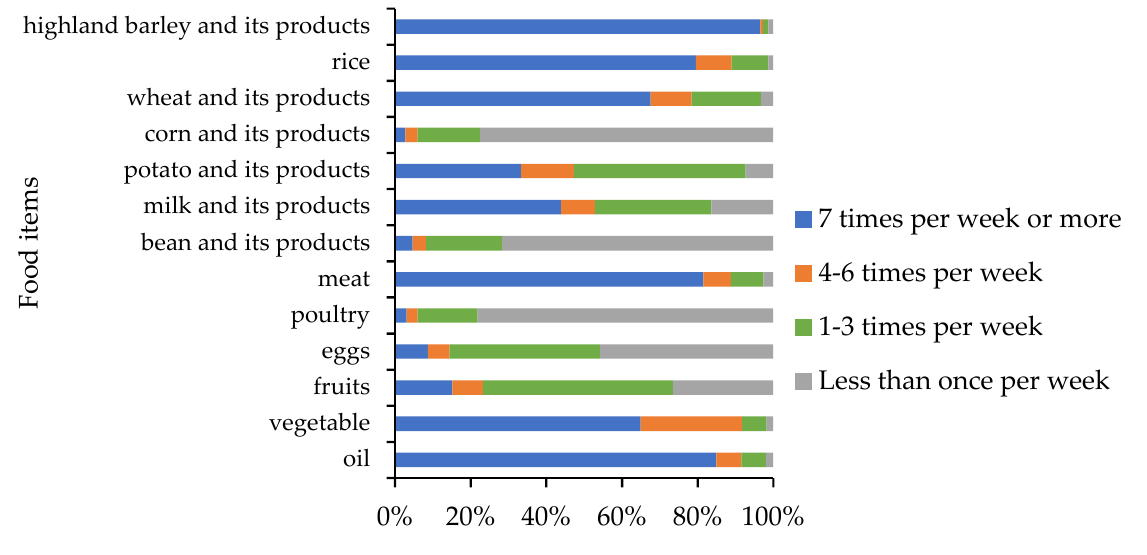
Figure 2. Food consumption frequency of the subjects ( n = 617).